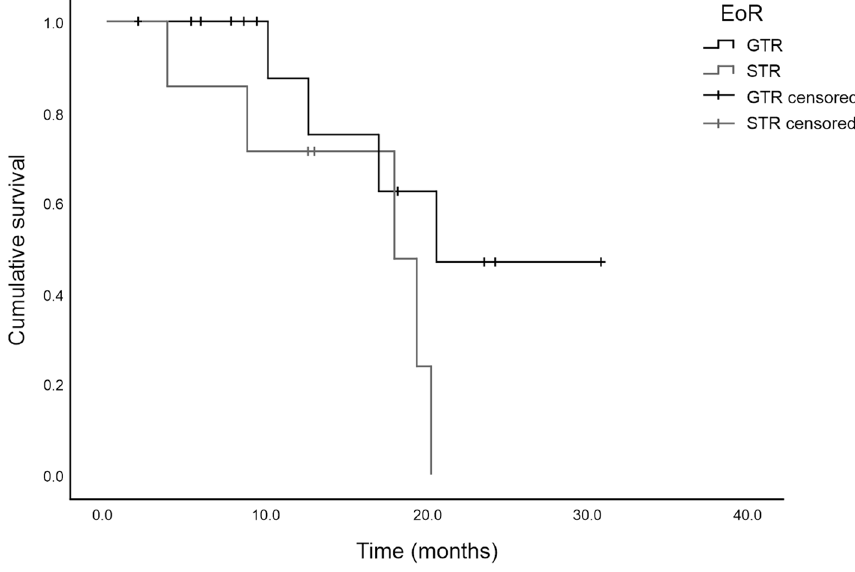
Figure 2. Kaplan–Meier survival curve for all 21 patients stratified by extent of tumor resection.